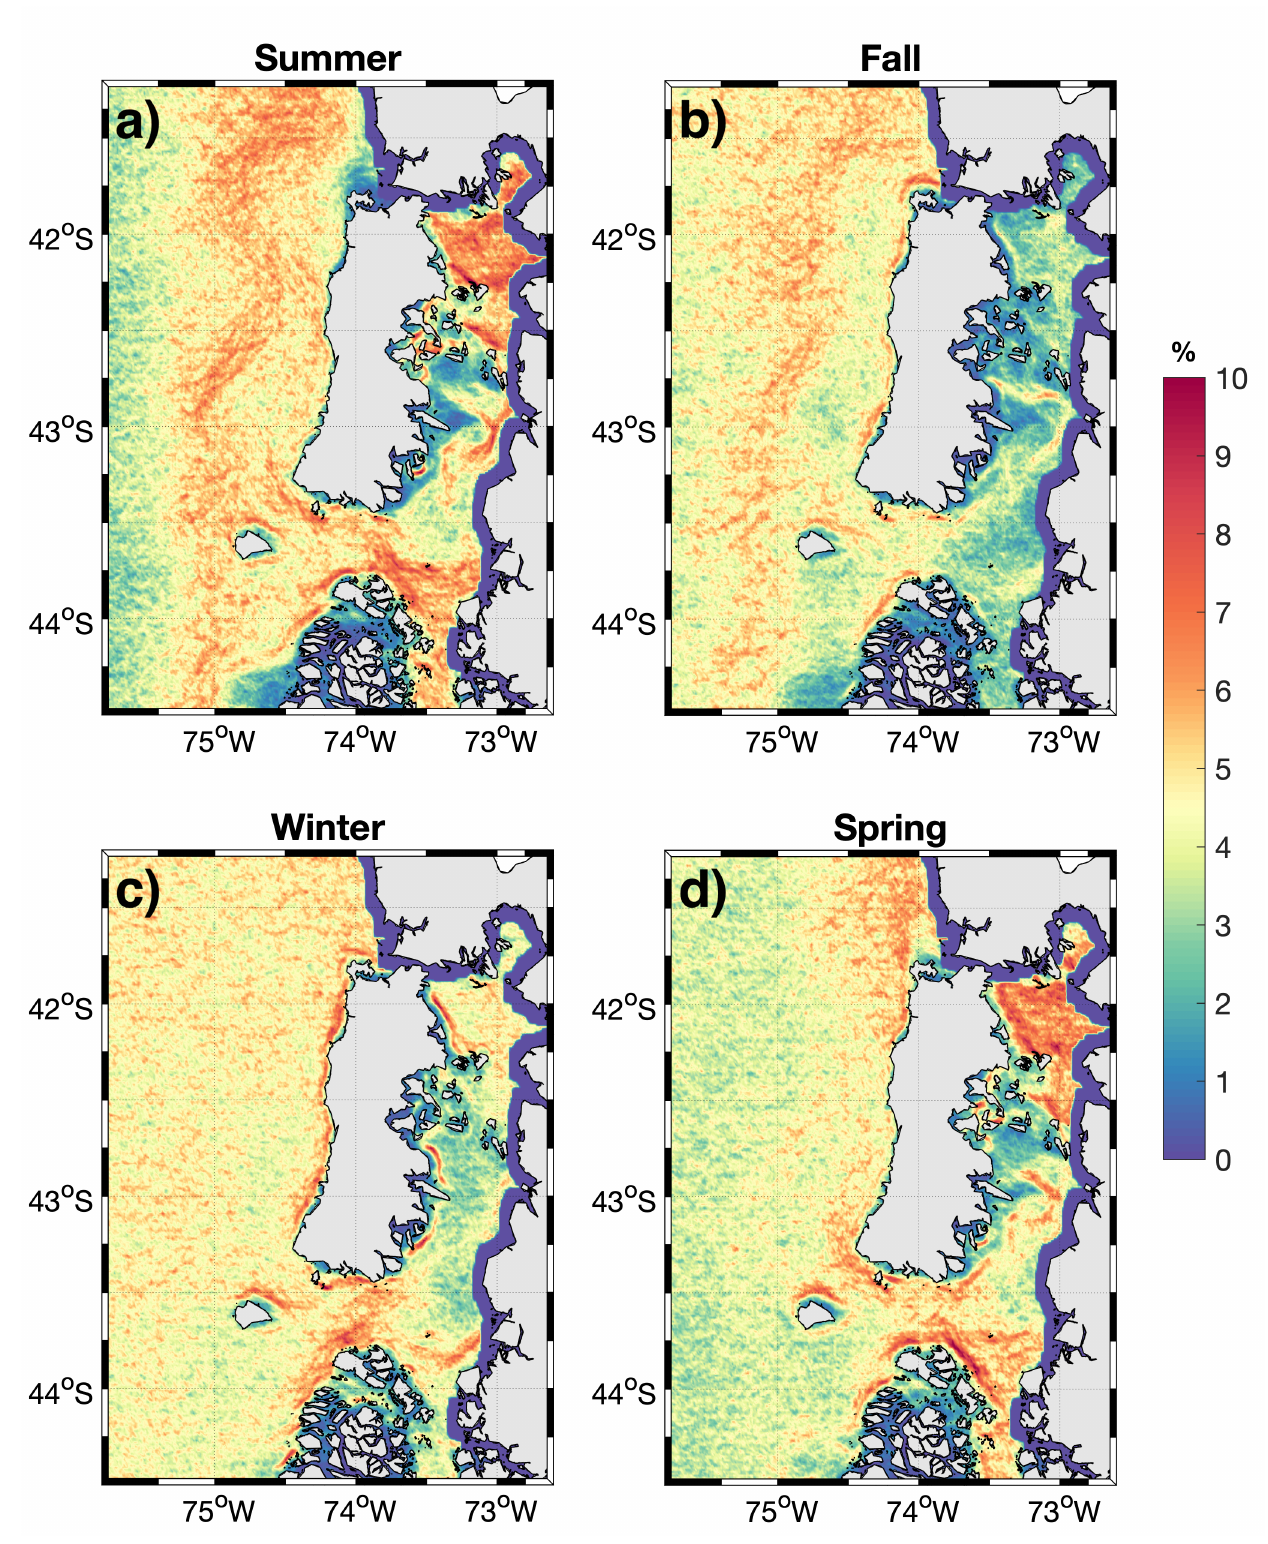
Figure 4. Seasonal climatology (2003–2019) of SST frontal probability (FP; %), based on the Canny edge-detection algorithm, in the Inner Sea of Chiloé and its adjacent coastal ocean for ( a ) summer (January, February, March), ( b ) fall (April, May, June), ( c ) winter (July, August, September), and ( d ) spring (October, November, December). For reference of locations see Figure